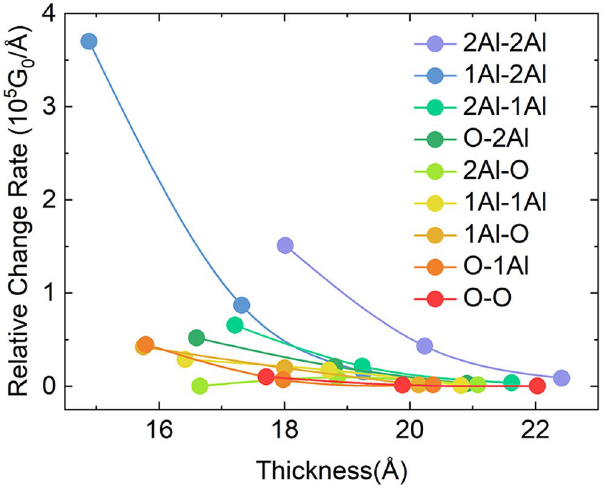
Figure 6. Relative change rates of conductance with increasing thicknesses for 9 termination mode models.